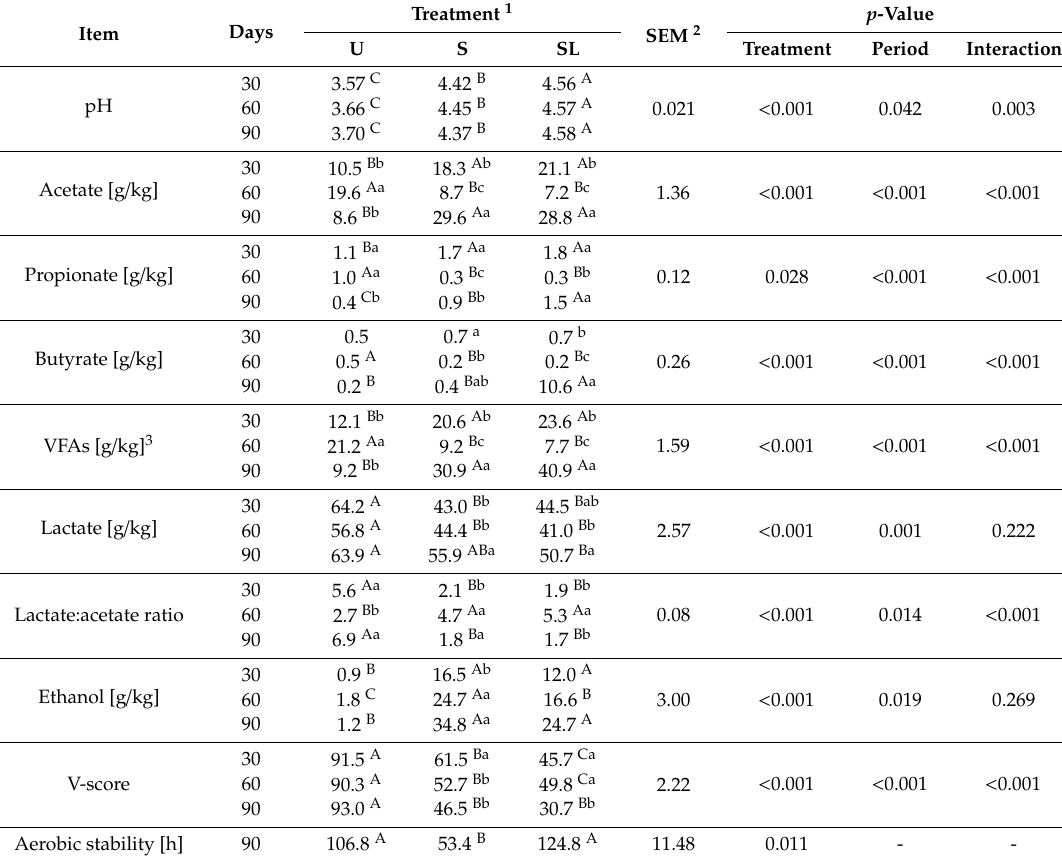
Table 3. The pH, organic acids, V-score, and aerobic stability of corn stalk silages ensiled for 30, 60, and 90 day (DM